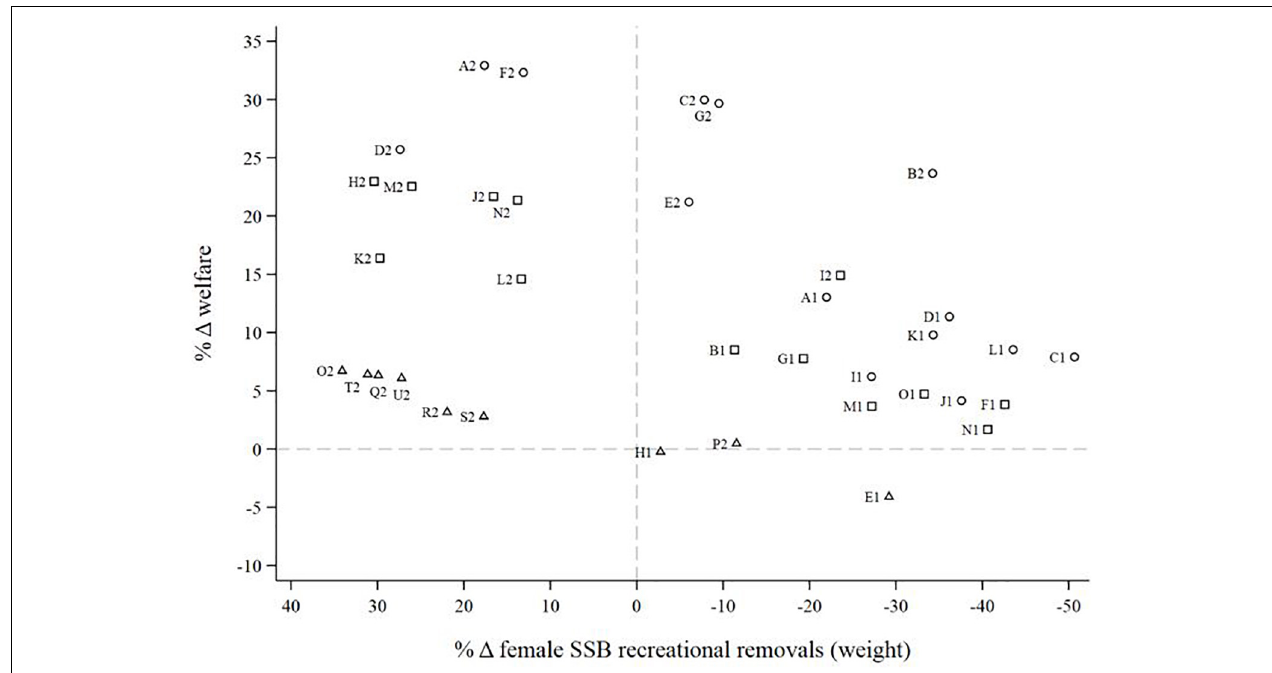
FIGURE 8 | Expected changes in welfare and female SSB removal weight under alternative 2015 policies in Massachusetts, Connecticut, and Rhode Island. See Table 6 for alternative policy definitions. Actual 2015 policy of one-fish, 28 (cid:48)(cid:48) or longer used as the baseline